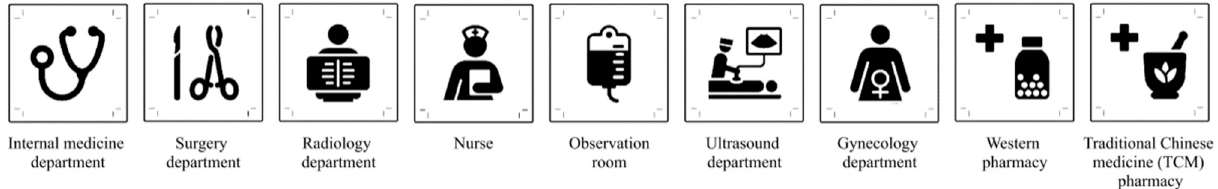
Figure 2. Healthcare wayfinding signs developed by the National Standard of the People’s Republic of China GB/T 10001.6-2021.